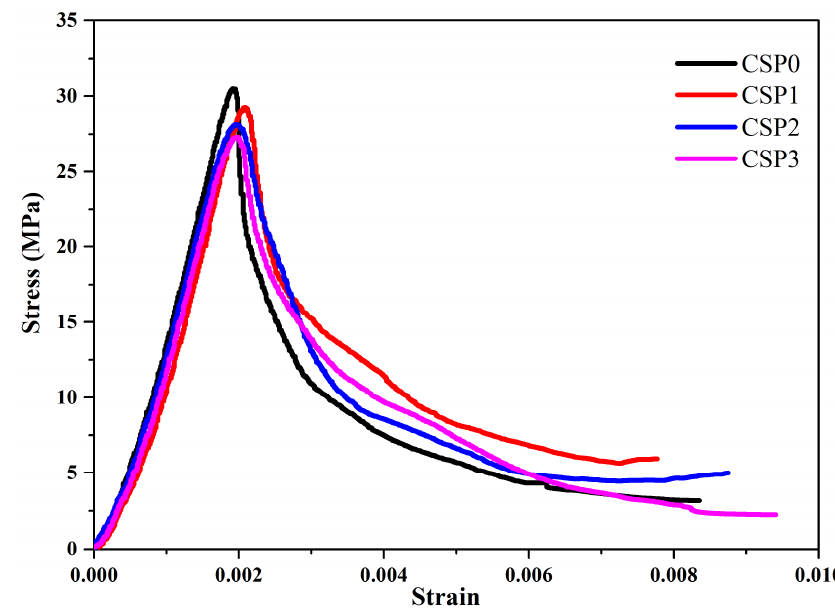
Figure 20. Stress–strain behavior of the control samples.